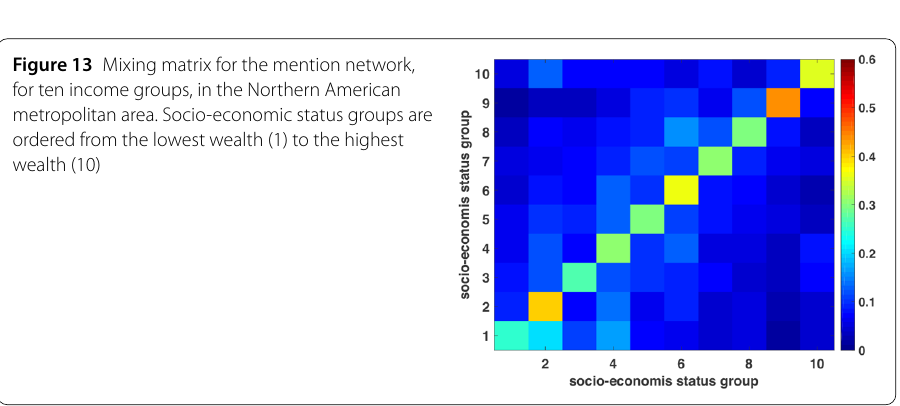
Figure 13 Mixing matrix for the mention network, for ten income groups, in the Northern American metropolitan area. Socio-economic status groups are ordered from the lowest wealth (1) to the highest wealth